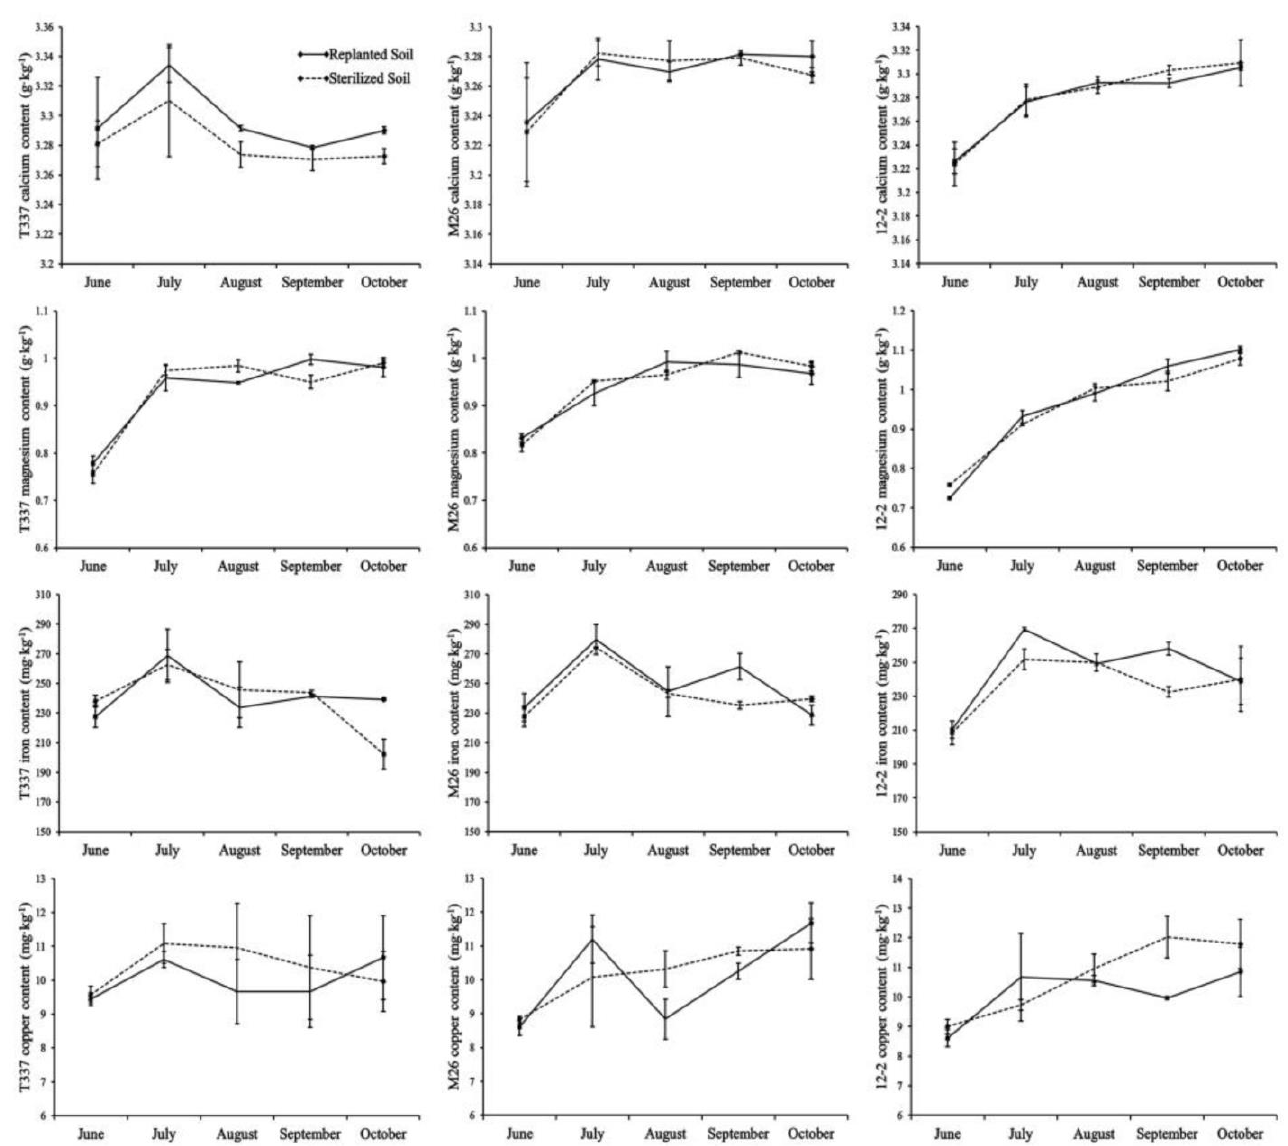
Figure 7. The mineral element content (calcium, magnesium, iron, and copper) in the leaves of plants with different rootstock types planted in sterilized and replanted soil.